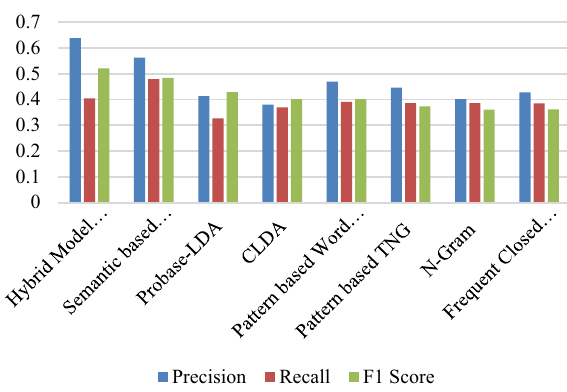
Figure 3. Result comparison of the proposed model with other